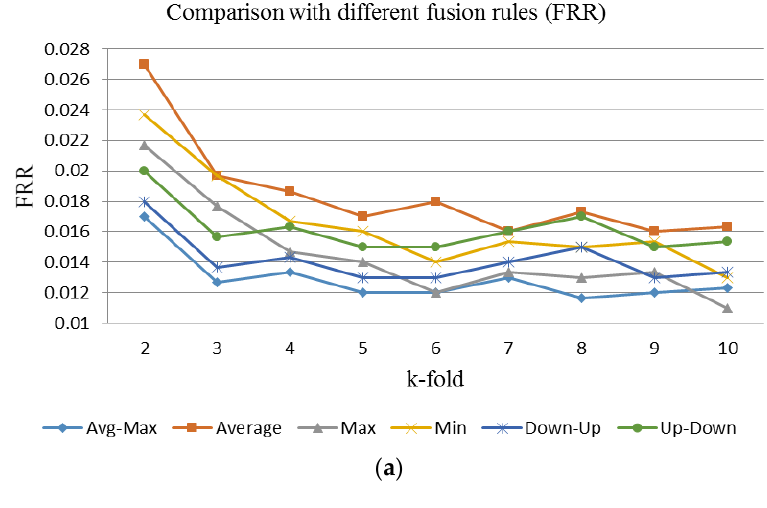
Figure 18. Cont. Figure 18. Cont.